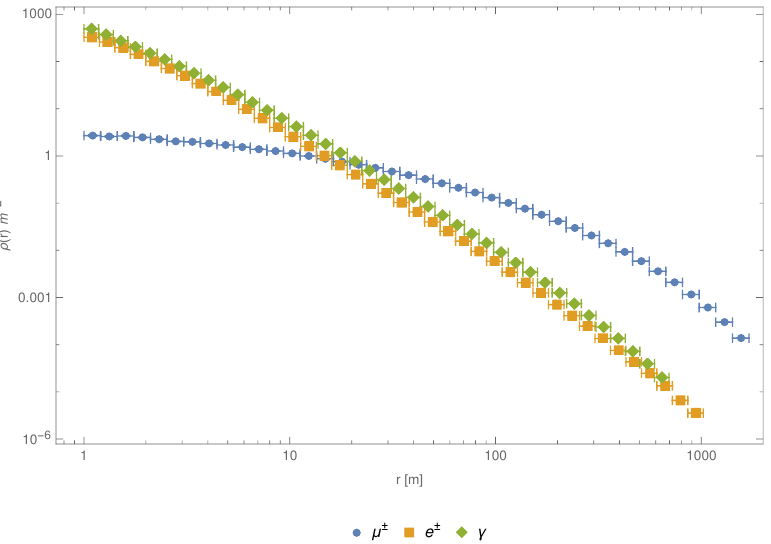
Figure 1. ρ ( r ) distribution of muons, electrons & positrons and photons from cascades initiated by protons with energy E = 4000 TeV, arriving at the zenith angle θ = 0 ◦ , as a function of the distance to the shower axis, r .